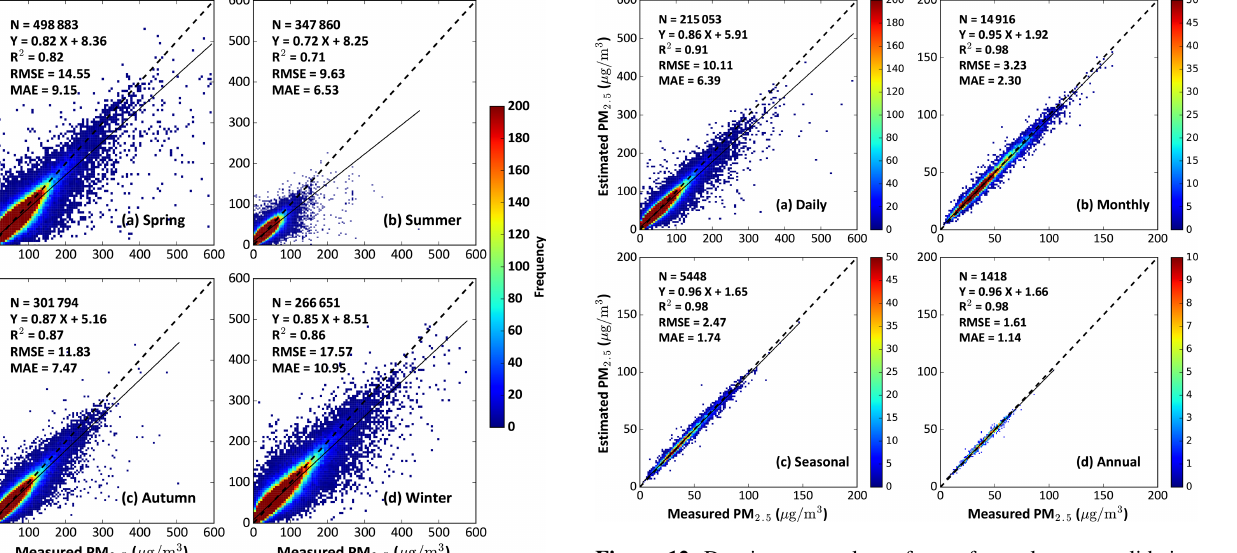
Figure 12. Density scatterplots of out-of-sample cross-validation results of (a) daily, (b) monthly, (c) seasonal, and (d) annual mean PM 2 . 5 estimates (µgm − 3 ) in 2018 across